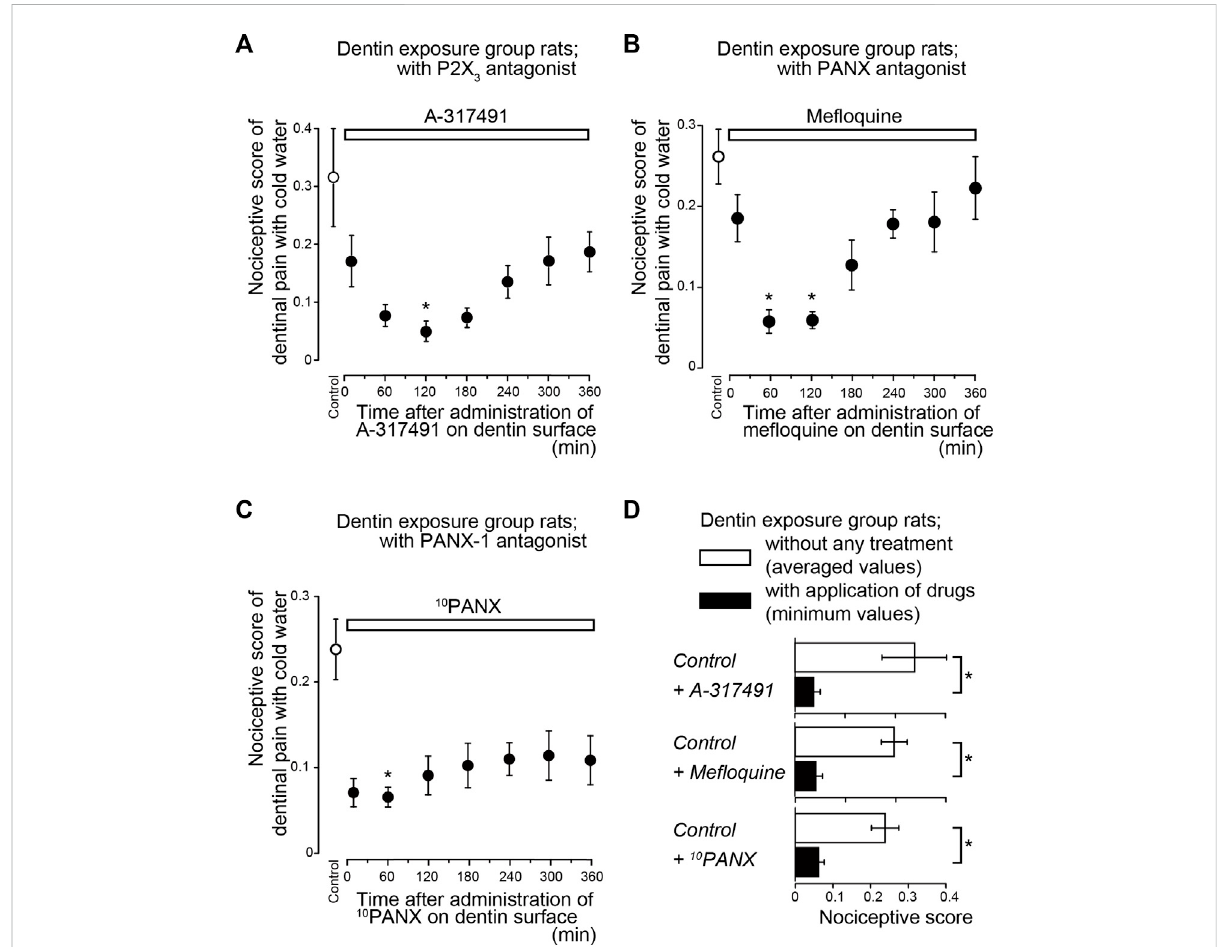
FIGURE 3 Time-dependence of pharmacological effects of P2X 3 receptor (A-317491) and PANX (me fl oquine and 10 PANX) antagonist on dentinal sensitivity (A – C) Time-dependent effects of A-317491 (A; n = 6, 0.3 nmol/g (weight) i.v.), me fl oquine (B; n = 7, 0.03 mg/g (weight) p.o.), and 10 PANX (C; n = 8, 2.58 nmol/g (weight) i.v.) (upper white boxes) on nociceptive scores following cold water stimulation. Prior to the systemic administration of A-317491, me fl oquine, or 10 PANX to the dentin-exposed rats, nociceptive scores were determined as the control values (white circles). Severalminutesafterthesemeasurements,A-317491 (A) ,me fl oquine (B) ,or 10 PANX (C) wasadministeredtotherats. Thecoldwaterstimuli-induced nociceptive scores were measured repeatedly at 10, 60, 120, 180, 240, 300, and 360 min later each (black circles in A to C; see also Materials and Methods). Each point denotes the mean ± SE of the number of experiments. Signi fi cant differences in the scores compared to control values are denoted by asterisks: * p < 0.05. (D) Summary bar graphs showing the mean nociceptive scores in the dentin-exposed group of rats without any treatment (control; withe columns) and their minimum values (during the entire period of administration) in dentin-exposed rats treated with A- 317491 ( n = 6), me fl oquine ( n = 7) and 10 PANX ( n = 8) (black columns). Each bar represents mean ± SE of the number of experiments. Signi fi cant differences between columns (shown by solid lines) are denoted by asterisks: * p <